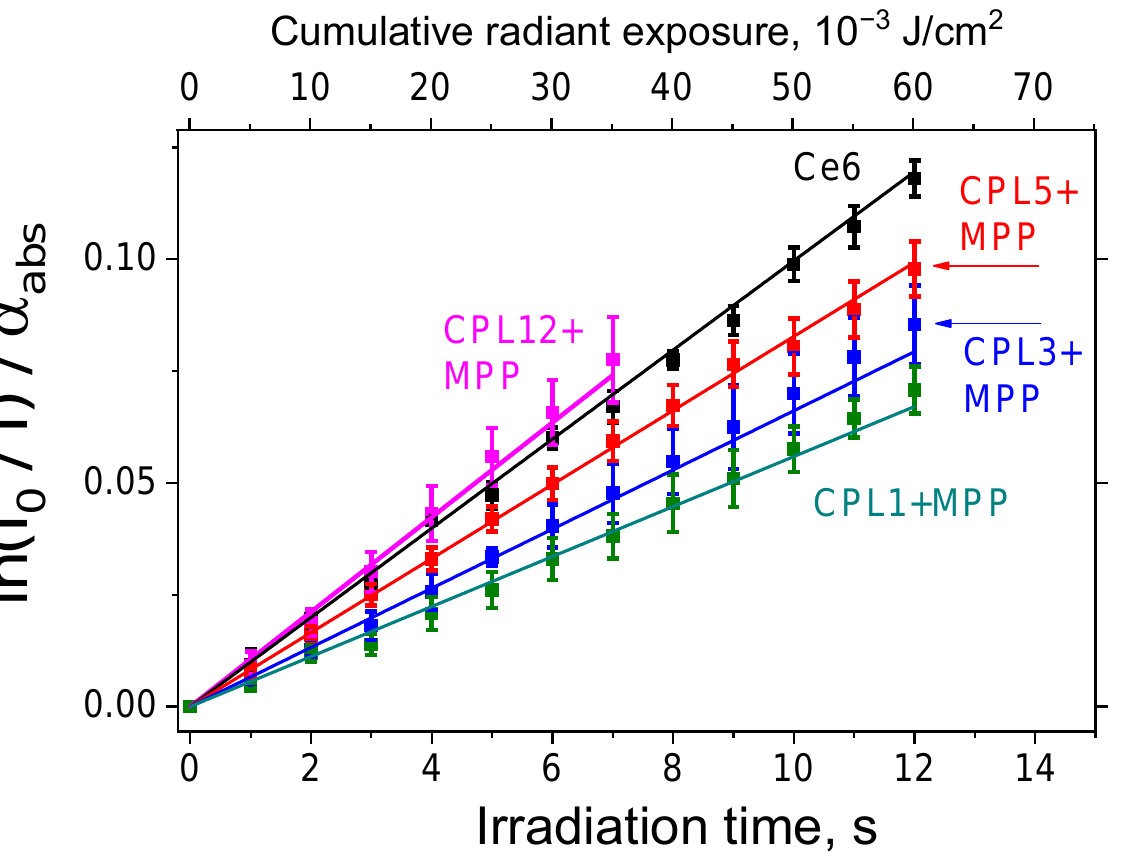
Figure 4. Kinetics of singlet oxygen generation, sensitized by nanoparticles under study or reference PS (Ce6) in water solution of lecithin liposomes with DPBF ( 1 O 2 probe) under red light irradiation (λ = 660 nm).